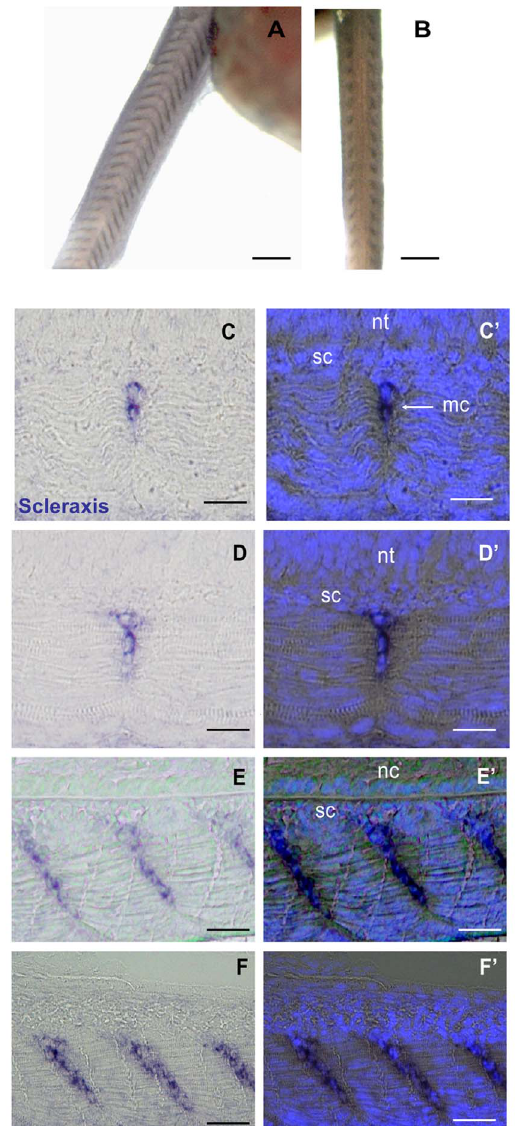
Figure 6. Expression of Scleraxis in myoseptal cells. Eyed stage (17dpf) embryo. ( A – B ) whole mount in situ hybridization. ( A ) Lateral view. ( B ) Dorsal view. Scleraxis is localised at the anterior and posterior myotome borders. ( C – F ) Serial frontal sections through the trunk of an eyed stage trout embryo. ( C ) A section at the dorsal neural tube level shows few labelled myoseptal cells medially in the intermyotomal space. ( D ) A section at the ventral neural tube level shows that labelled myoseptal cells are visible within the medial half of the intermyotomal space. ( E ) Sections at the level of the notochord and ( F ) ventral to the notochord show that labelled cells are present throughout the medio- lateral extent of the intermyotomal space. ( C 9 – F 9 ) Merged images showing Scleraxis labelling and Hoechst nuclear staining; there is no labelling in skeletogenic cells immediately adjacent to the neural tube and notochord. nt: neural tube; n: notochord, mc: myoseptal cell; sc: skeletogenic cells. Scale bars in A, 300 m m; B, 200 m m Scale bars in C, C 9 , D and D 9 , 25 m m; E, E 9 , F and F 9 , 40 m m.